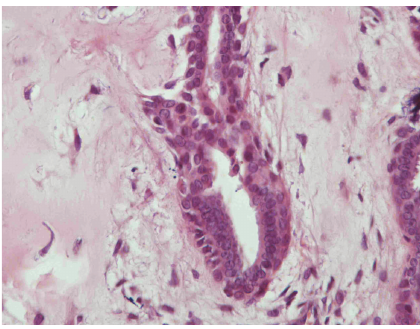
Figure 8: Hyaline mesenchymal